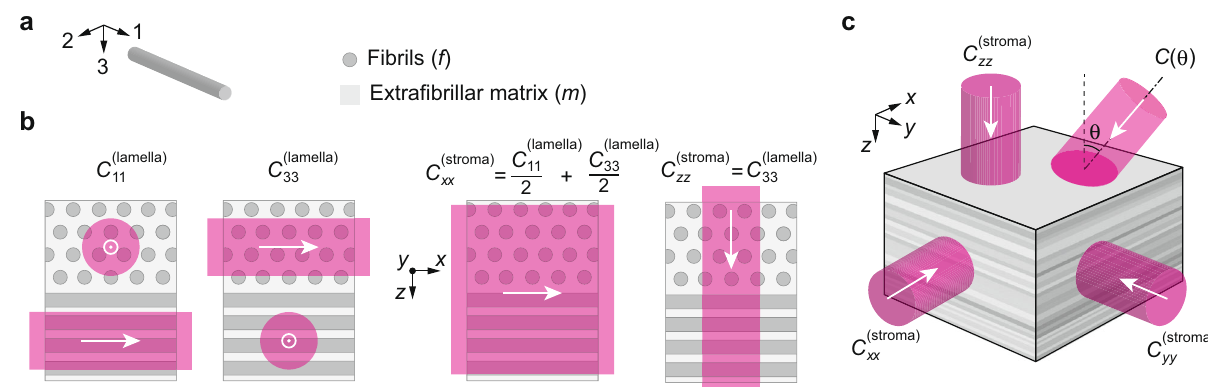
Fig. 1 Brillouin measurements at different laser incidence angles detect tissue anisotropy. a Within each lamella, collagen fi bers ( f ) are co-aligned within a gel matrix ( m ). We de fi ne a coordinate system (1 – 3) for each lamella in which the 1-direction is always aligned with the fi bril axis. b The elastic modulus in the 1-direction C 11 is different than the moduli orthogonal to the fi bril axis, C 22 and C 33 . By reducing the laser spot size, it is possible to resolve individual lamellae using Brillouin microscopy. When the laser spot size covers multiple lamellae, we measure a combined modulus. For the bulk stroma we de fi ne the z -direction as orthogonal to the cornea and the x − y plane as tangential. c Cut-away view through the stromal depth showing stacked lamellae. The cornea is mechanically anisotropic, meaning that the longitudinal moduli ( C ii ) have directional dependence. This can be probed using Brillouin microscopy with varying laser incidence angle θ